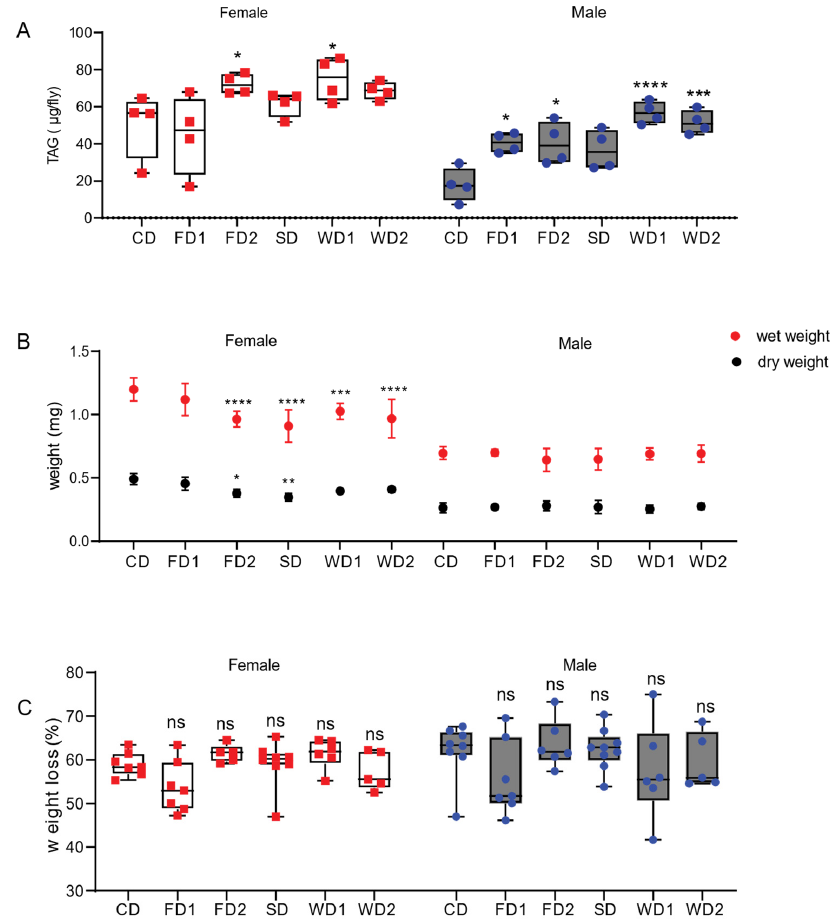
Figure 1. TAG levels and body weights in adult male and female flies exposed to diets supplemented with sugar, fat, or a combination of both. ( A ). TAG concentrations in adult male and female Dahomey flies exposed to normal diet (CD), fat (coconut oil)-supplemented diet (FD1 and FD2), (sucrose) sugar-supplemented diet (SD), and western diets (WD1 and WD2). TAG levels were expressed as µ g TAG per fly in females and males. Box plots display the medians, and whisker plots indicate the minimum and maximum values. Western diets significantly increased TAG levels in males and females. p -values were determined using two-way ANOVA. Main effects: diet, p < 0.0001; sex, p < 0.0001 and their interaction; ns, with a Dunnett’s multiple comparisons test comparing the data on the diets to CD per sex. * p < 0.05, *** p < 0.0005, **** p < 0.0001. ( B ) Mean wet and dry weights of adult male and female Dahomey flies exposed to the diets. The body weights of 5 flies were measured in at least 5 replicates per sex per condition. The weight per fly was calculated per replicate. The data are shown as the mean and the SD. The fat and/or sugar-supplemented diets reduced the body weights of females, but not those of males. Statistical analysis was conducted using two-way ANOVA for wet weight data and dry weight data separately. For the wet weight, main effects were: diet, p < 0.0001; sex, p < 0.0001 and their interaction; p = 0.0002. For the dry weight, main effects were: diet, p < 0.0001; sex, p < 0.0001 and their interaction; p < 0.0001. p -values were calculated using Dunnett’s multiple comparisons test comparing the data on the diets to those on the CD (0S0F) per sex. * p < 0.05, ** p < 0.005, *** p < 0.0005, **** p < 0.0001. ( C ) The percentage of body weight that was lost after dehydration (dry weight). The percentage of lost bodyweight was not significantly different in the flies on the diets as compared to those on the CD. The data are shown as box and whiskers plots displaying the median, minimum, and maximum values. p -values were determined using two-way ANOVA. Main effects: diet, p = 0.03; sex, ns and their interaction; ns, with a Dunnett’s multiple comparisons test comparing the data on the diets to those on the CD (0S0F) per